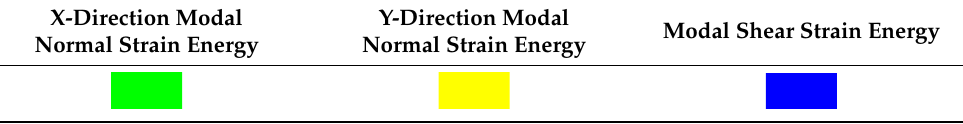
Table 1. Colors corresponding to the modal strain energy.